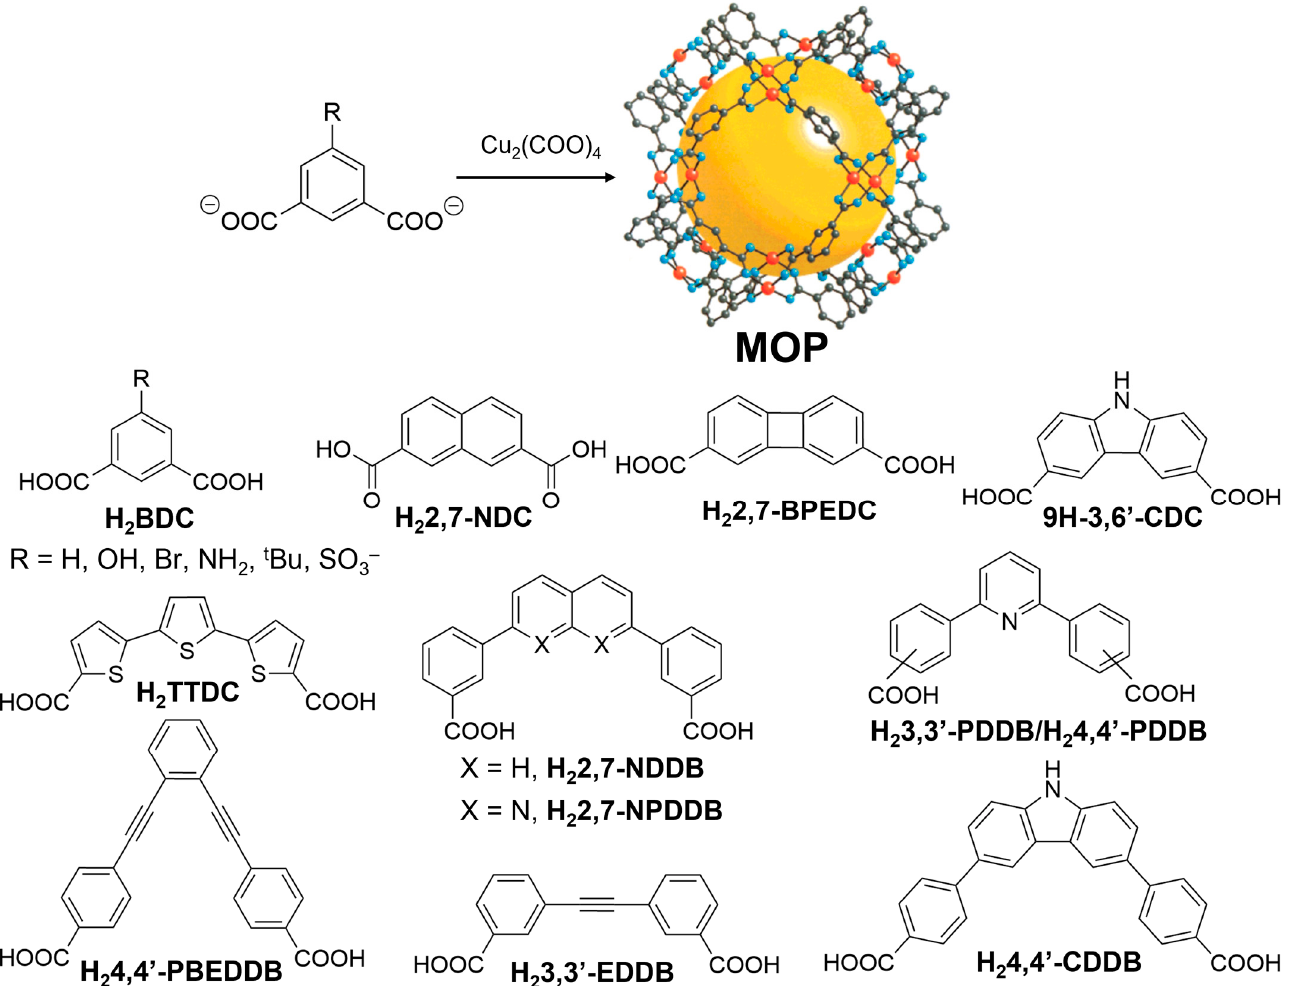
Figure 5. (Top) General designing of metal-carboxylate self-assembled MOP prepared from 5-substituted benzene 1,3-dicarboxylate and dimetallic paddlewheel cluster. (Bottom) Several ditopic carboxylic acid linkers used to prepare diverse class of metal-organic polyhedra (MOPs). Reprinted by permission from Ref. [22]. Copyright 2001 from American Chemical Society.